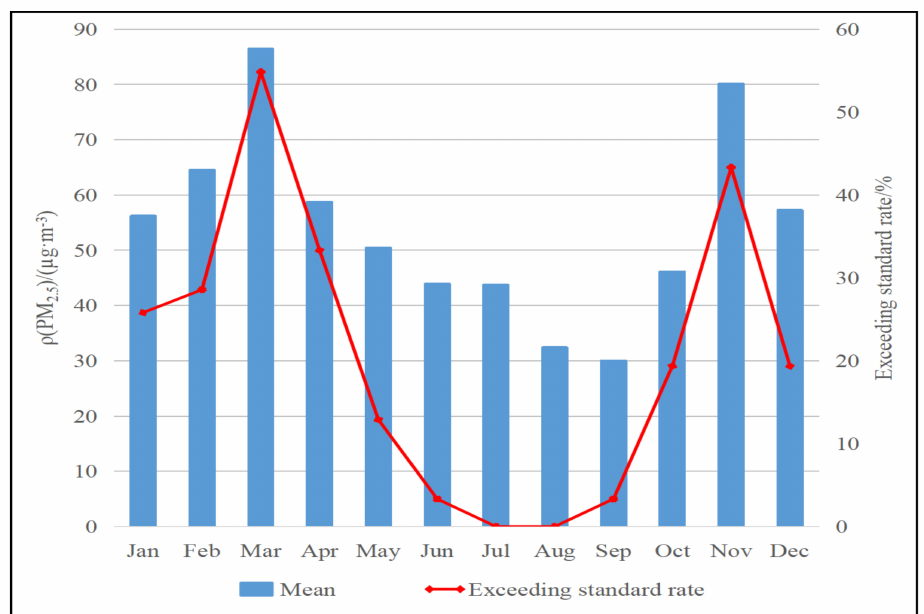
Figure 2. Mean, maximum, and minimum monthly PM 2.5 concentrations, as well as the percent of days exceeding standards, for the Beijing-Tianjin-Hebei region in